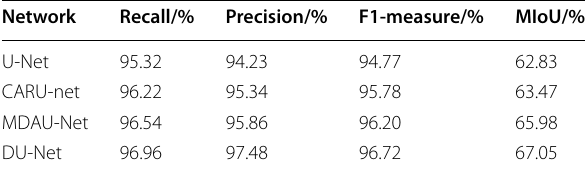
Table 6 Massachusetts dataset accuracy evaluation